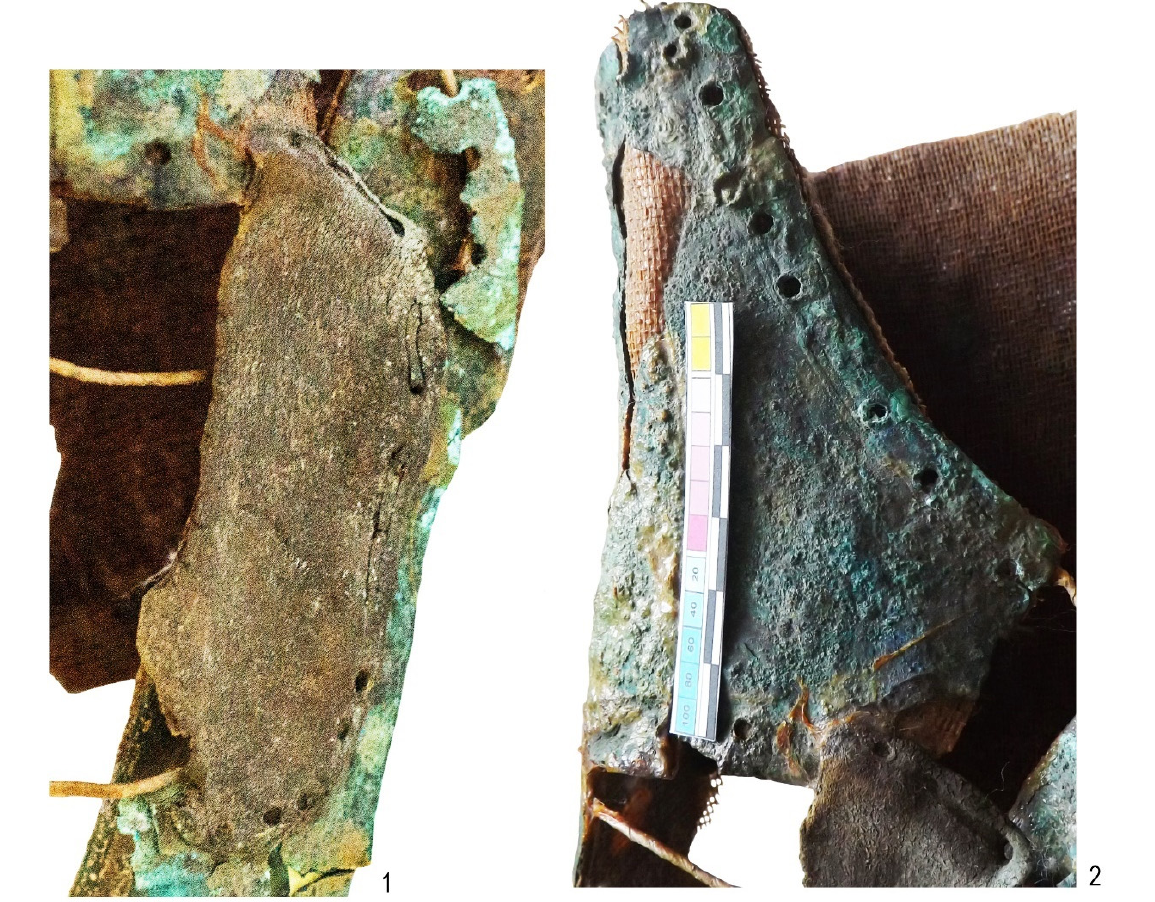
Figure 8. Vodoslavka Barrow 6 Burials 1–2. The right greave. Details: leather overlay covering the lateral opening (1); upper lateral section (2) (photograph T. Shelemeteva).